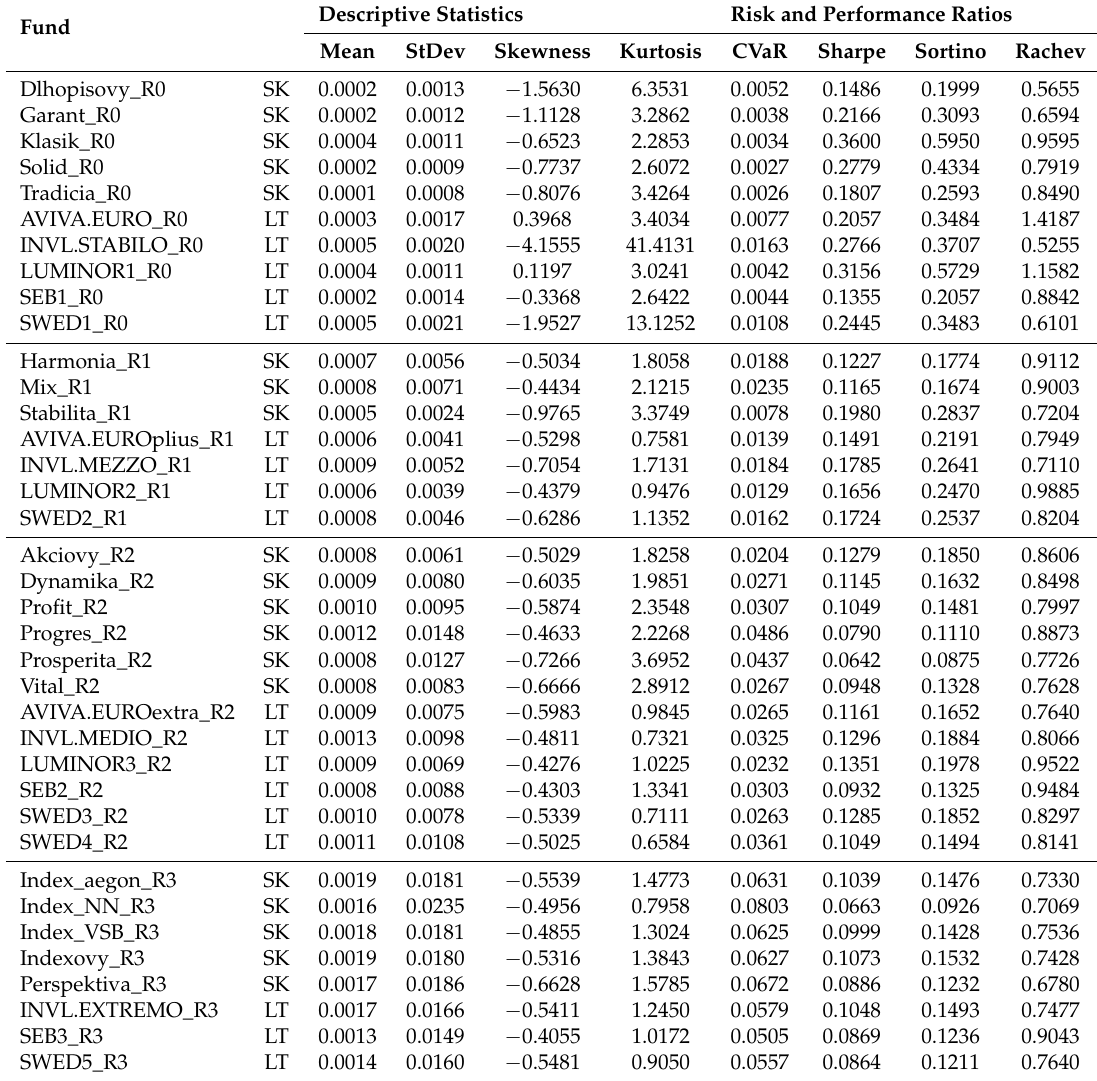
Table 3. Empirical characteristics: mean, standard deviation (stdev), skewness, kurtosis, conditional Value-at-Risk (CVaR), Sharpe, Sortino and Rachev of PFs arranged by established risk groups.